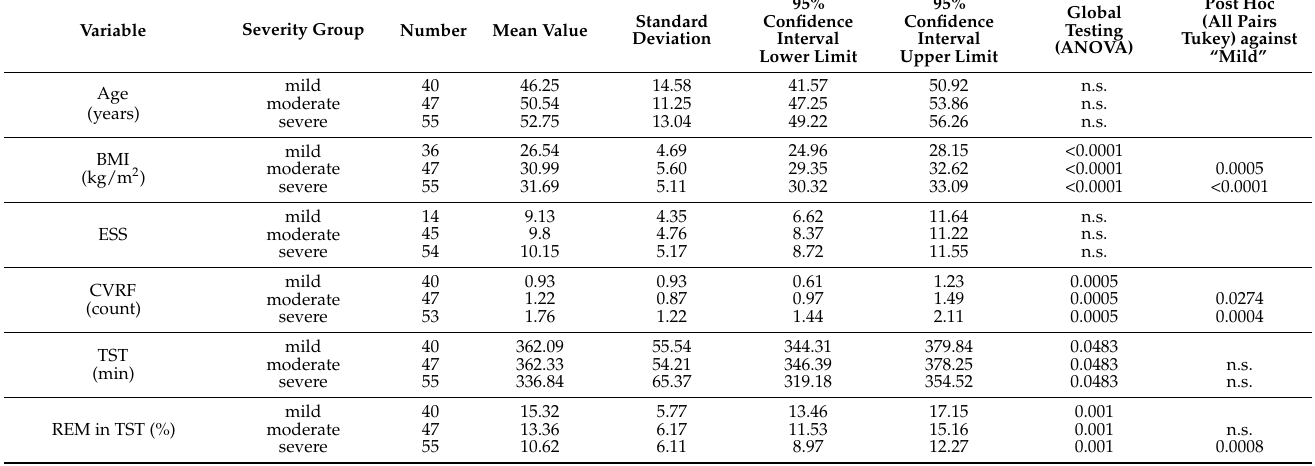
Table 1. The epidemiological data of the 141 patients divided in the severity groups (mild, moderate, and severe) showing the variables age in years, BMI in kg/m 2 , ESS (Epworth Sleepiness Scale) on a scale from 0 to 24, TST (total sleep time) in minutes, TST in REM as a percentage, the proportion of sleep time in supine position of TST as a percentage, and the sleep efficiency as a percentage. The CVRF value stands for the number of cardiovascular risk factors. These were counted according to the patient’s health history (e.g., hypertension, obesity, hyperlipoproteinemia, diabetes mellitus). If the patient has two risk factors, the CVRF value is equal to 2. Besides the grouping, the number of patients, the mean value, the standard deviation, and the upper/lower 95% confidence interval are shown. To test for significance, the analysis of variance (ANOVA) was used together with the Tukey HSD test. We compared the moderately and severely affected groups against the mildly affected group. n.s.: not